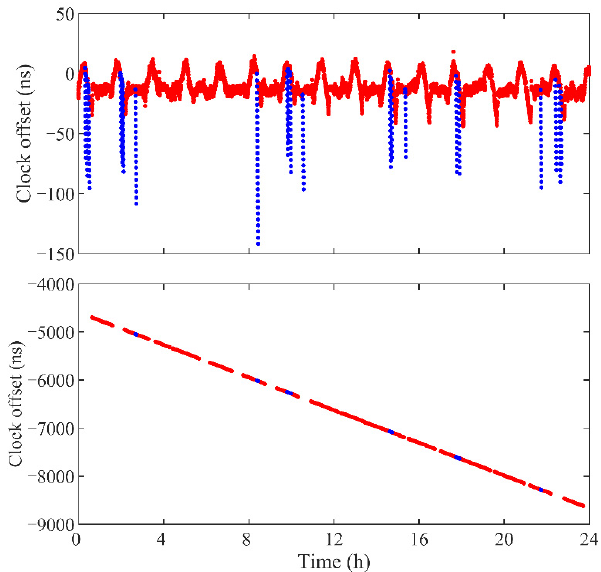
Figure 13. Clock offsets of TH-2A (on DOY 308, 2019) obtained from POD based on GPS observations ( top panel ) and BDS2 observations without correction ( bottom panel ). Blue and red points show the estimated clock offsets when radar is in operation and powered off, respectively.